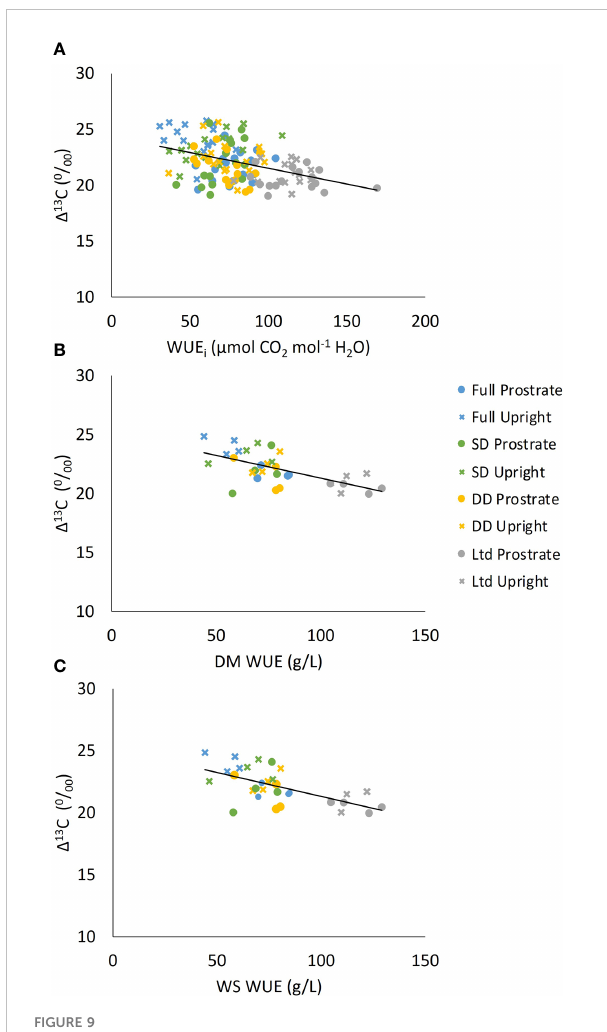
FIGURE 9 The relationship between carbon isotope discrimination ( D 13 C) and (A) intrinsic water use ef fi ciency (WUE i ) (P<0.001 R 2 = 0.17), (B) Dry matter water use ef fi ciency (WUE DM ) (P=0.001 R 2 = 0.30) and (C) White sugar yield water use ef fi ciency (WUE WS ) (P=0.004 R 2 = 0.24). Two sugar beet varieties were grown under four different irrigation regimes and are plotted as one data set but presented so that the different varieties and treatments can be identi fi